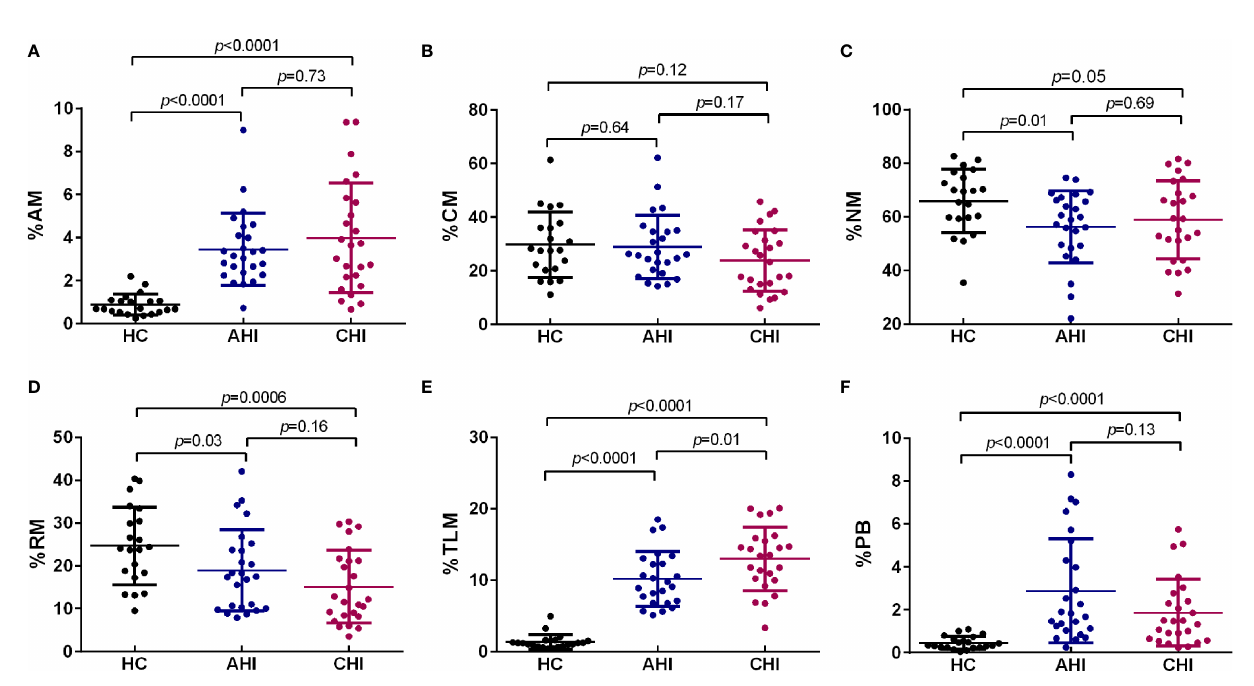
FIGURE 2 | HIV-1 acute infection drives B cell subsets perturbation. Comparison of AM (A) , CM (B) , NM (C) , RM (D) , TLM (E) , and PB (F) among HC (n=21), AHI (n=25), and CHI (n=25) groups. AM, activated memory B cells; CM, classical memory B cells; NM, naive B cells; RM, resting memory B cells; TLM, tissue-like memory B cells; PB, plasmablasts. All data shown are means ±